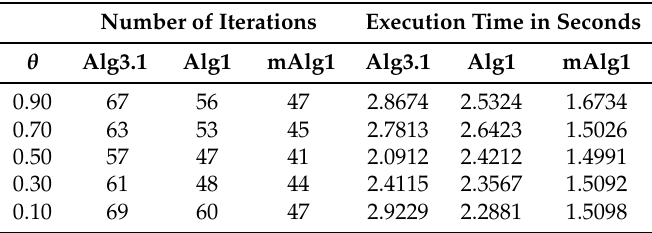
Table 3. Example 2: Algorithm 1 (mAlg1) numerical comparison with Algorithm 3.1 (Alg3.1) in [39] and Algorithm 1 (Alg1) in [38].